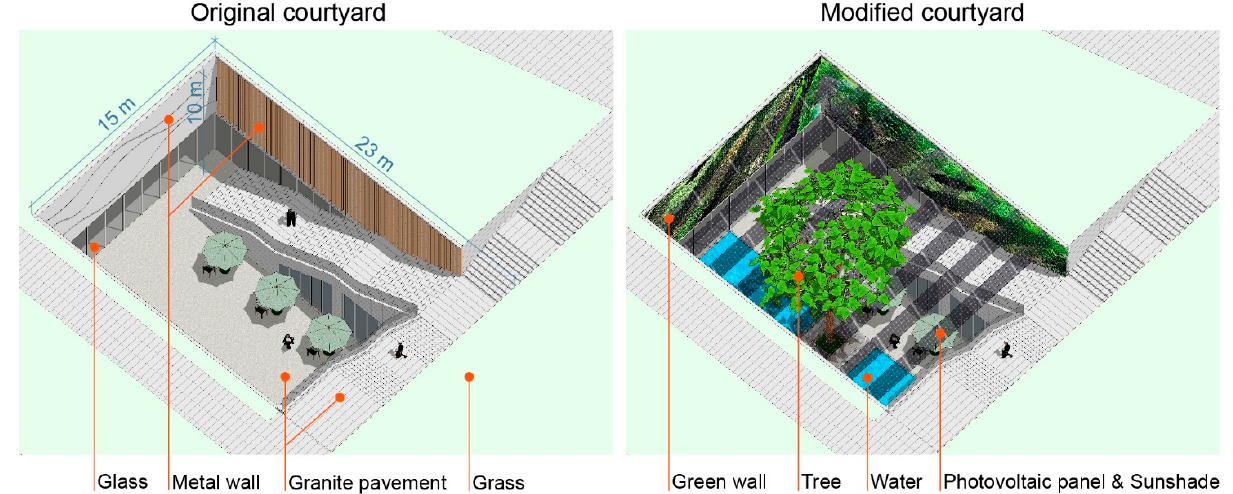
Figure 2. Models of original and modified courtyards. Table 4. Environmental parameters required by ENVI-met simulation.